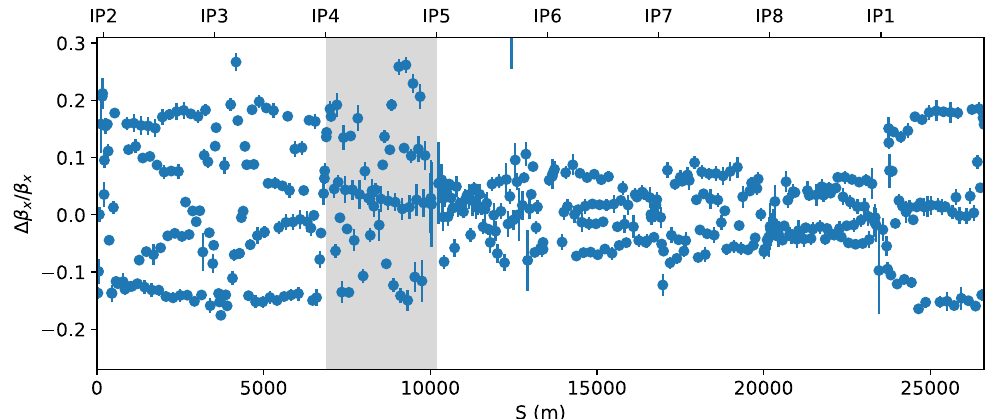
FIG. 16. Horizontal β -beating measurement at flat 60 = 15 cm optics with local and global corrections applied, performed during the 2017 flat optics MD. The grey area shows the arc 45. In this area the corrections were unable to bring the β -beating below